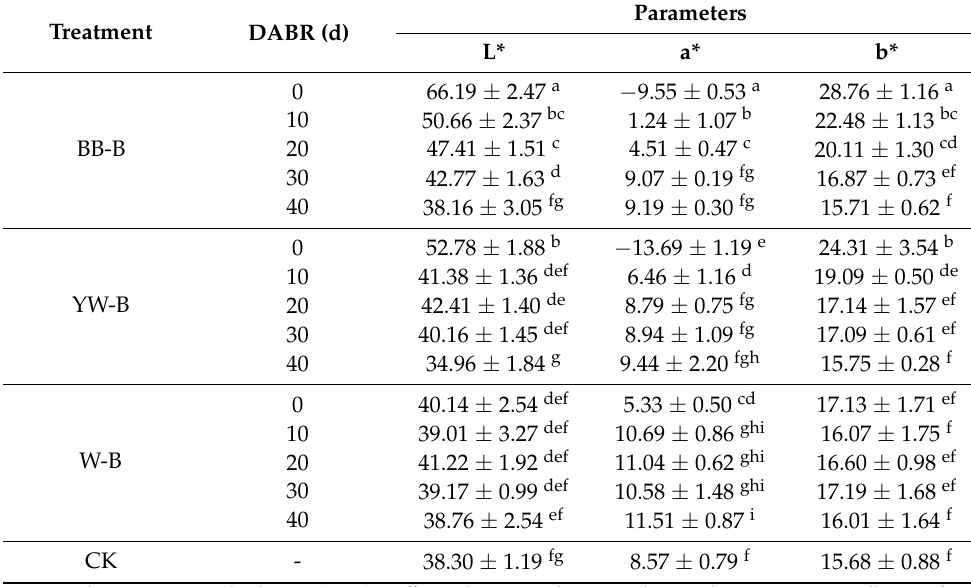
Table 1. Color parameters among ‘Xinqihong’ pear fruit bagged with three types of fruit bag for different periods.